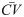
CV¯ computed from the training (a) and test (b) datasets across the different age groups (juveniles, adolescents, young adults and adults) and for the different versions of the data (baseline, binary and standardized). The different age groups are associated with different colors and the value of CV¯ is represented by a circle having a radius proportional to the predicted population size.